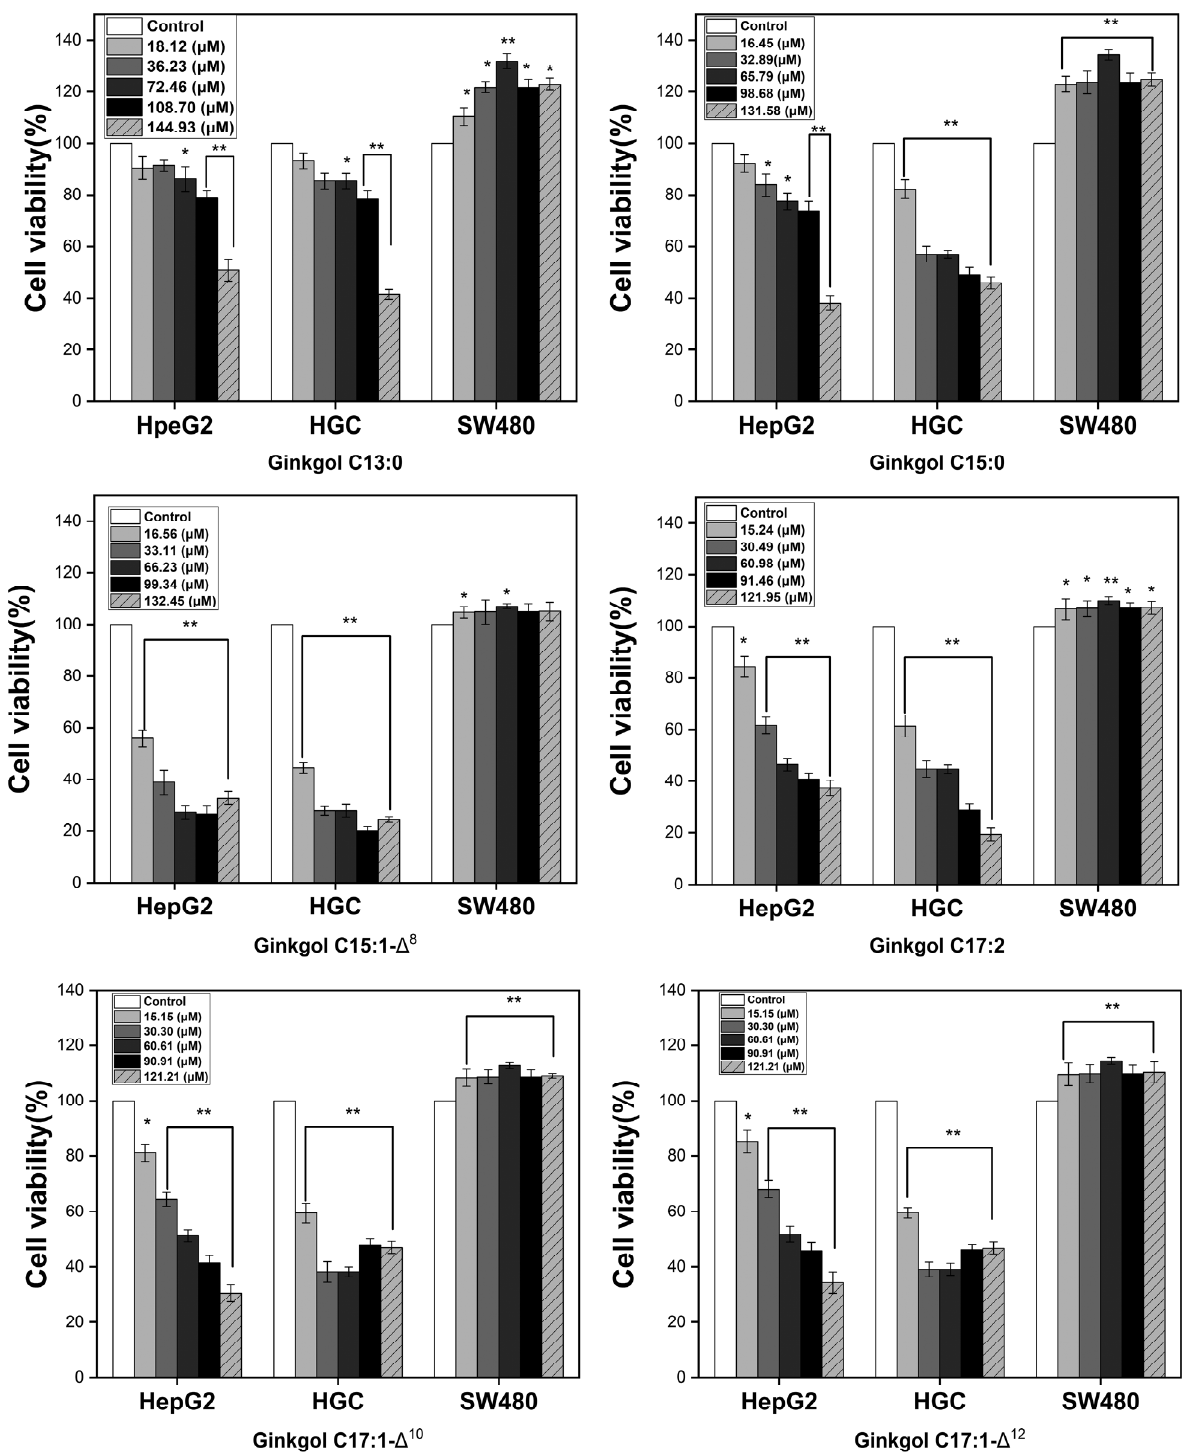
Figure 7. Inhibitive effects of ginkgol C13:0, C15:1- Δ 8 , C17:2, C15:0, C17:1- Δ 10 , and C17:1- Δ 12 on HepG2, HGC, and SW480 cell lines at different concentrations. * p < 0.05 vs. control. ** p < 0.01 vs. control.